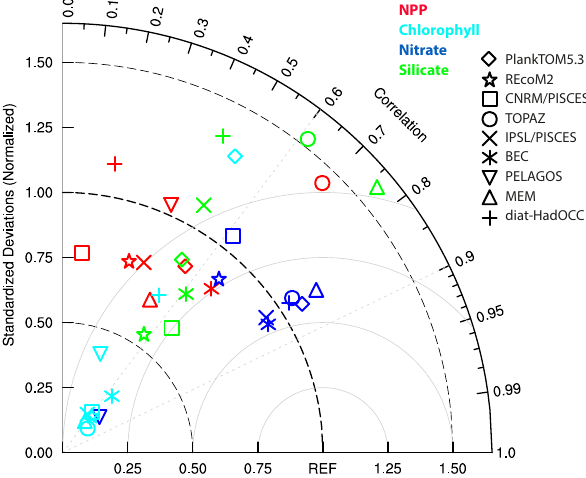
Figure 1. Taylor diagram showing the model–data correspondence for NPP (red), surface chlorophyll (light blue), NO 3 (dark blue) and SiOH 4 (green). The data-based estimates are from WOA2013 for NO 3 and SiOH 4 , from the SeaWiFS Project for chlorophyll and from Westberry et al. (2008) for NPP. We compare nutrients for the 1990–1999 period, while chlorophyll and NPP data are from 1997 to 2006. The angular coordinate shows the correlation coefficient, the distance from the origin denotes the normalized standard de- viation and the distance from point [1.1] describes the root mean squared